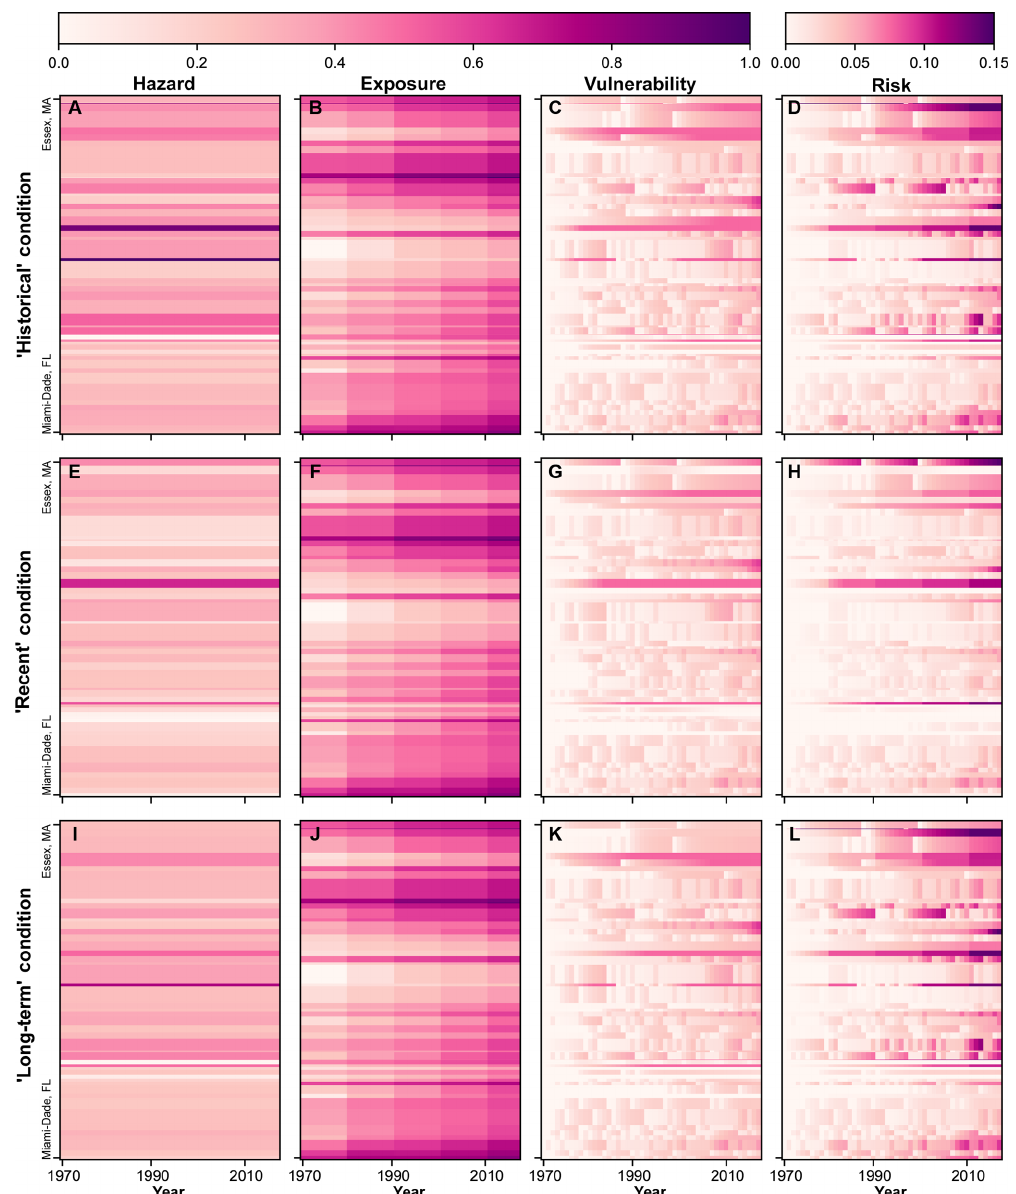
Figure 2. Columns show hazard, exposure, and vulnerability components and resulting risk. Each row of panels illustrates a different rate of shoreline change (i.e. hazard condition): (a–d) historical, (e–h) recent, and (i–l) long term. Risk in Norfolk County, MA, exceeds the maximum scale bar value of 0.15 (2016 risk = 0.418; see Table 1). Each county is scaled by the number of 1km transects it comprises; the northern- and southernmost counties are